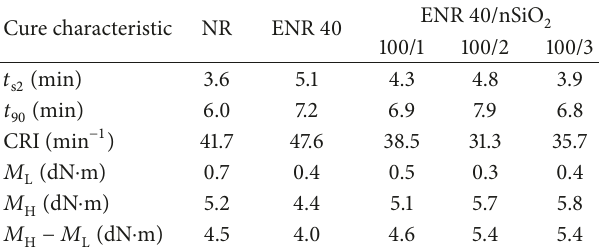
Table 2: Cure characteristics of NR, ENR 40, and ENR 40/nSiO 2